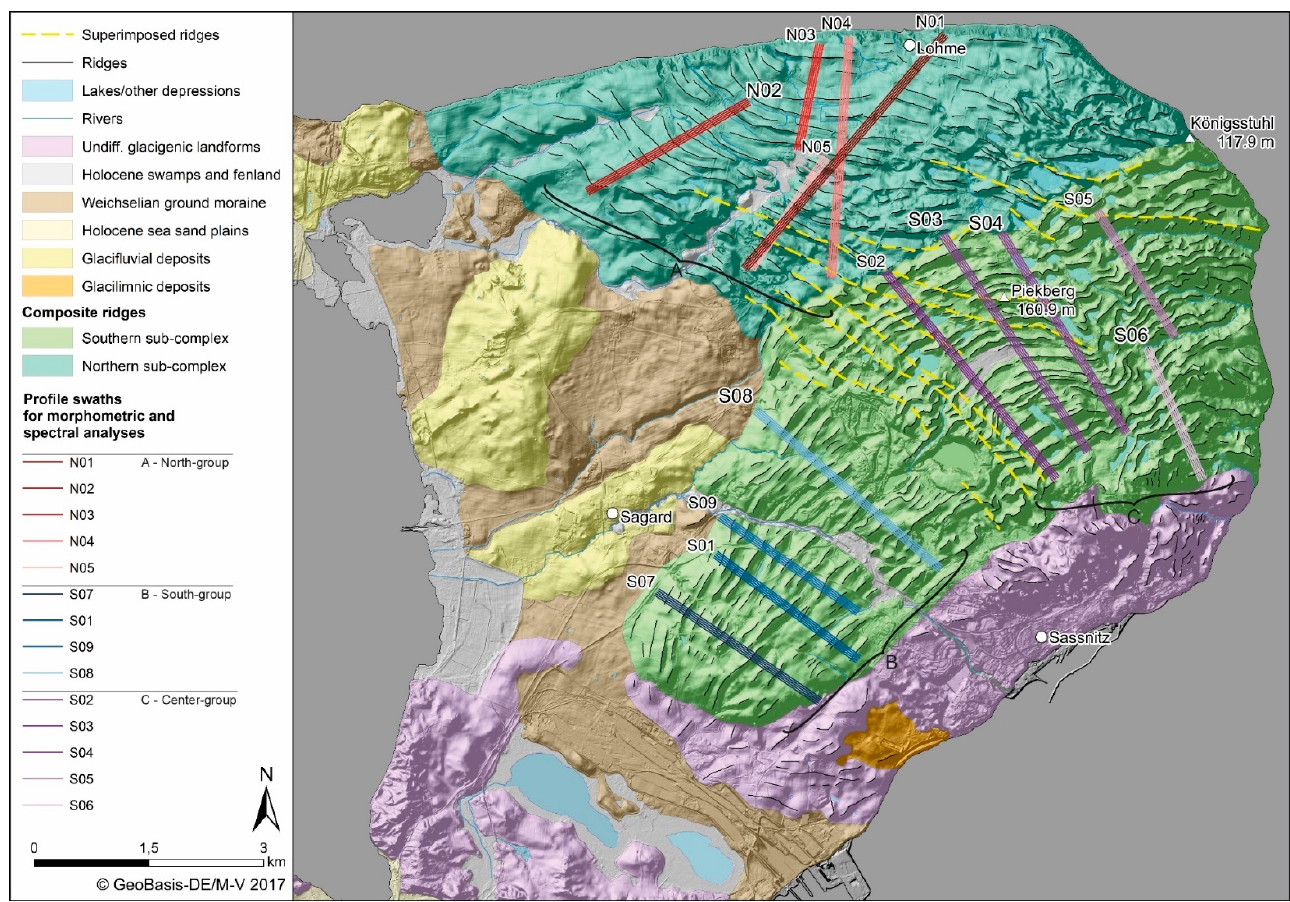
Figure 5. Geomorphological map of the Jasmund Peninsula with the digital elevation model with a resolution of 5 m (DEM5) as background. The separation into the northern (turquoise) and southern (light green) sub-complexes is evident by the changes in ridge orientation. Profiles used for morphometric and spectral analyses in the northern (N01–N05) and southern sub-complex (S01–S09) are shown in different colors (North-group: red, South-group: blue, Center-group: violet).